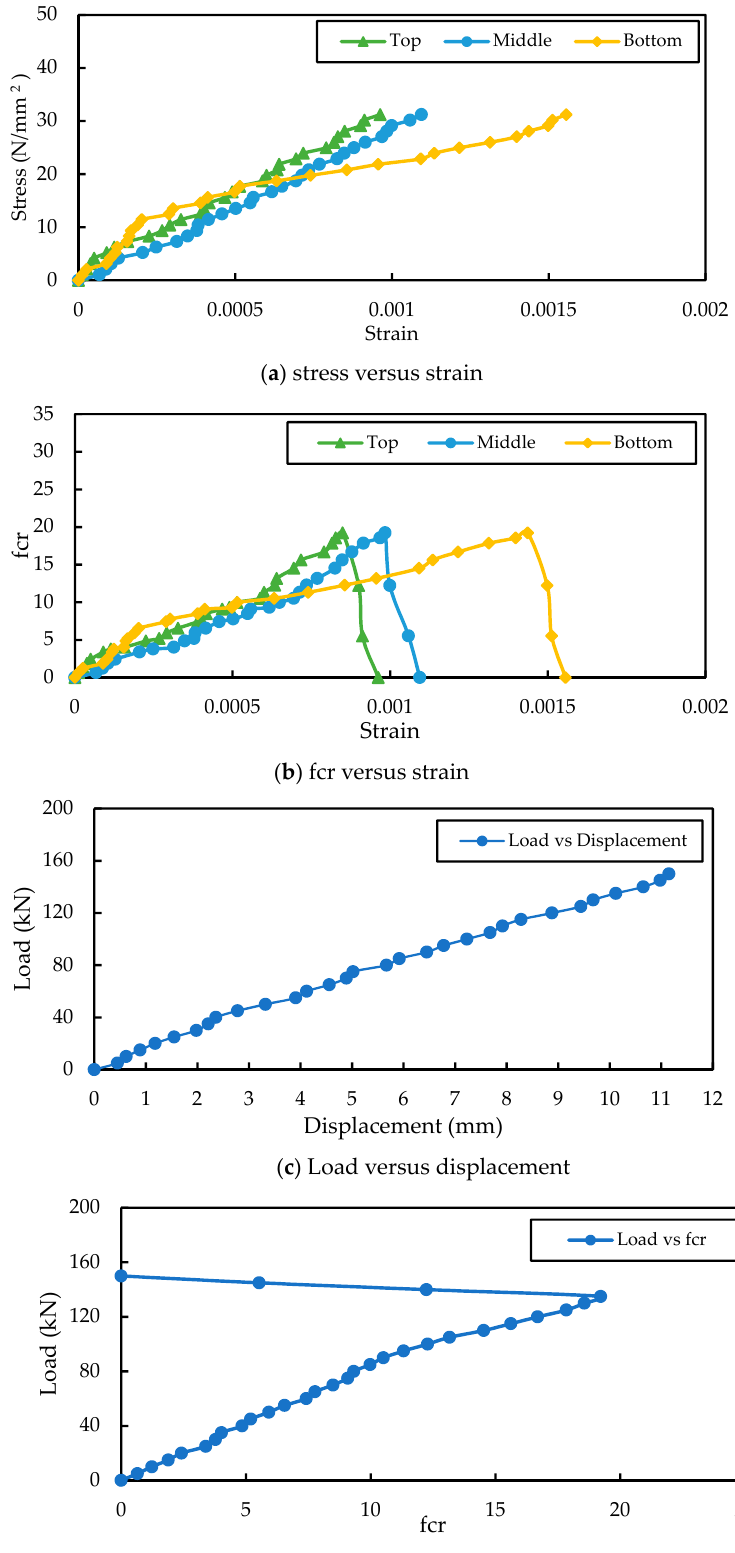
Figure 12. Graphical representation of ( a ) stress vs. strain, ( b ) fcr vs. strain, ( c ) load vs. displacement, and ( d ) load versus fcr behaviour of hybrid brass–carbon fibre-added mortar layer pasted on existing concrete beam with Araldite paste of length 1.5 m.